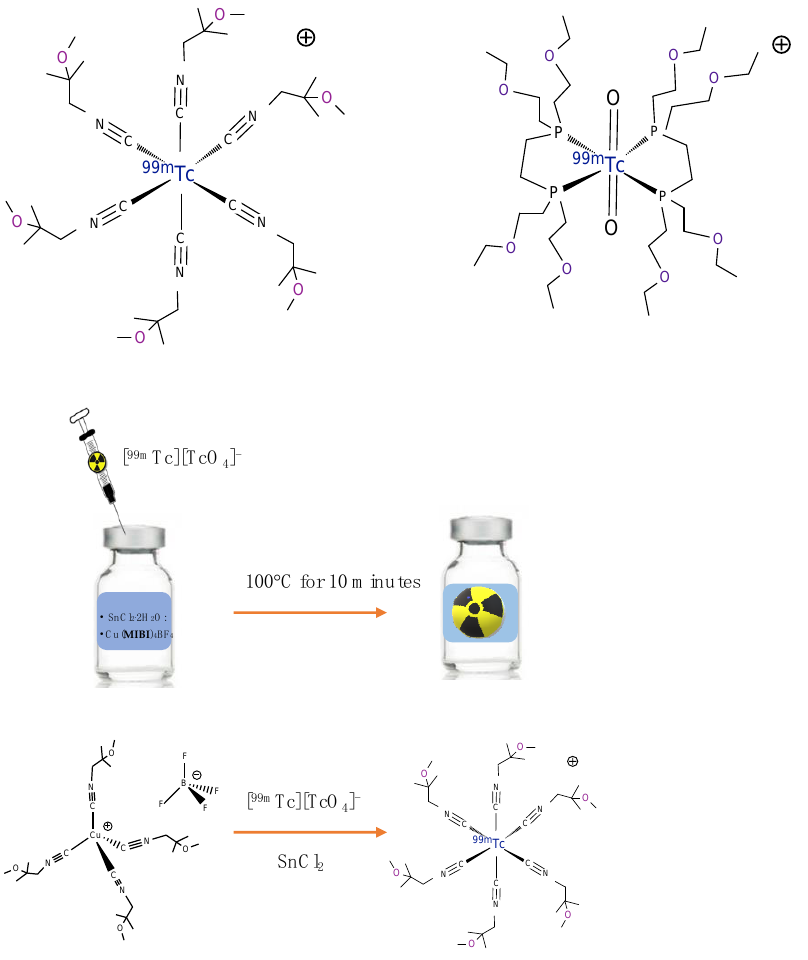
Figure 1. Chemical structure of [ 99m Tc]Tc-Sestamibi ( left ) and [ 99m Tc]Tc-Tetrofosmin ( right ), and a schematic representation of the preparation of [ 99m Tc]Tc-Sestamibi.